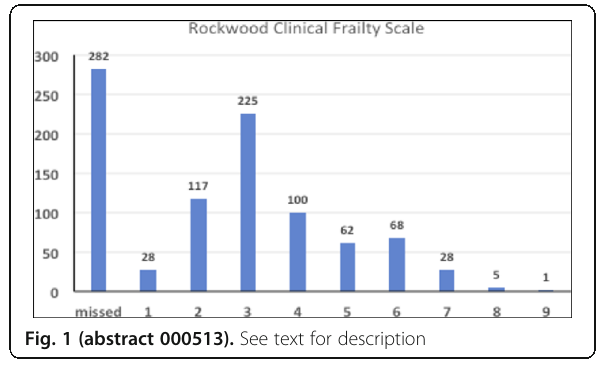
Fig. 1 (abstract 000513). See text for